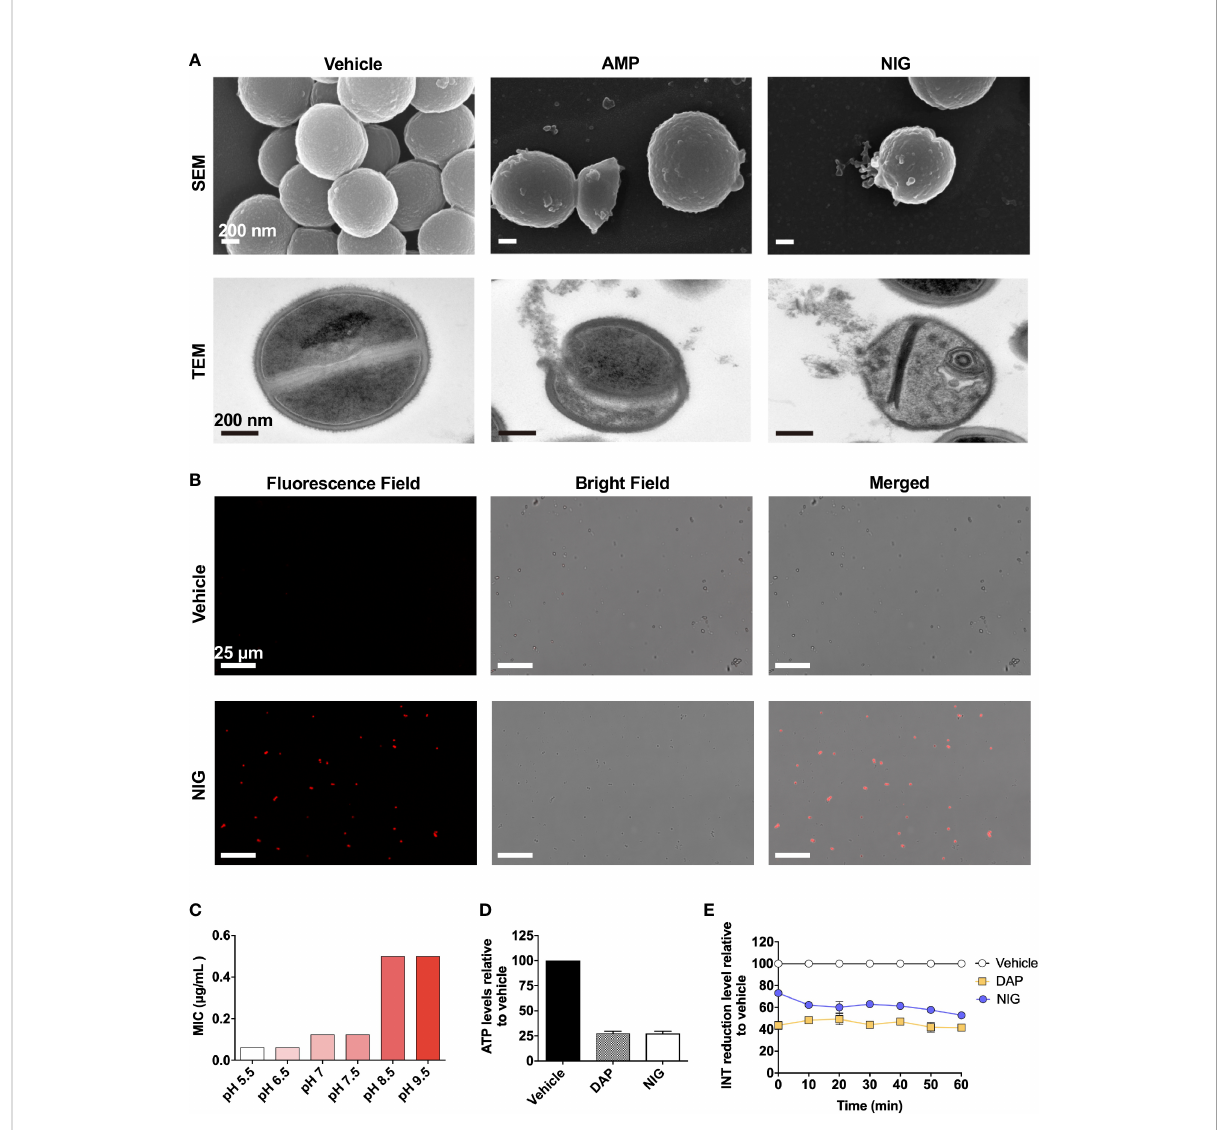
FIGURE 4 Nigericin disrupts membrane integrity. (A) Electron microscopy. SEM and TEM showing S. aureus RN450 upon treatment with nigericin (NIG; 4 × MIC, 6 h), ampicillin (AMP; 6 × MIC, 9 h) or vehicle (0.1% EtOH, 6 h). Images are representative of 208 recordings from three independent experiments. Scale bar, 200 nm. (B) Propidium iodide staining. S. aureus RN450 cultures were incubated with vehicle (0.1% EtOH) or nigericin (NIG; 8 × MIC) for 7 h and then stained with propidium iodide, and observed with a fl uorescence microscope. Scale bar, 25 m m. (C) Effect of extracellular pH on nigericin MIC with S. aureus RN450. (D) Effect of nigericin on intracellular ATP levels. S. aureus RN450 was treated with daptomycin (DAP, 1 × MIC), nigericin (NIG, 1 × MIC), or vehicle (0.1% EtOH) for 1 h. (E) Effect of nigericin on relative reduction of the